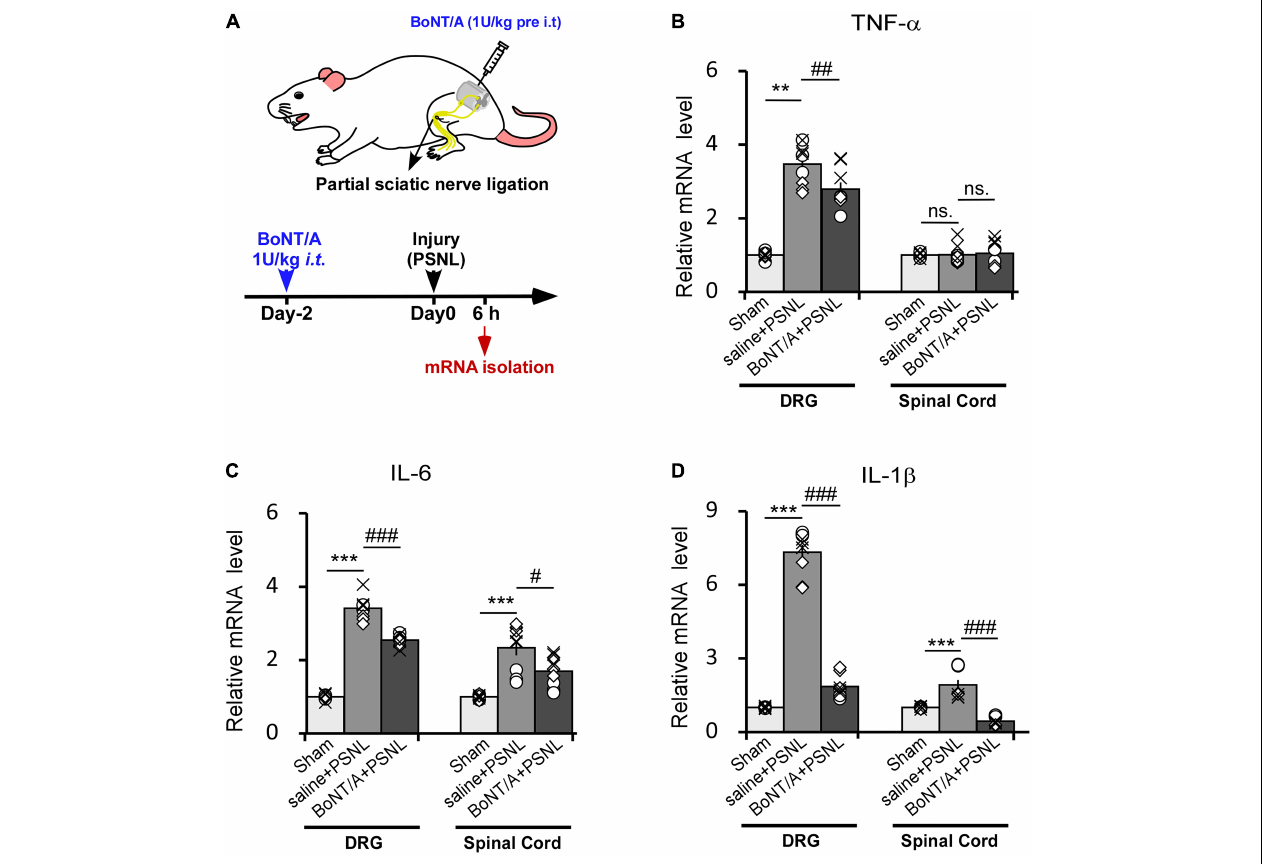
FIGURE 3 | Intrathecal pre-administration of BoNT/A partially prohibits partial sciatic nerve ligation (PSNL)-induced pro-inflammatory cytokine release in rat DRGs and the spinal cord dorsal horn. (A) A schematic illustration showing the protocol where BoNT/A was intrathecally ( i.t. , 1 U/kg) injected into spaces between the L5 and L6 spinal segments 2 days before PSNL surgery in rats. Six hours after PSNL surgery, the total mRNA was extracted from the DRGs and ipsilateral spinal cord dorsal horn, and the mRNA expression levels of the pro-inflammatory cytokines were detected. (B–D) mRNA expression levels of TNF- α (B) , IL-6 (C) , and IL-1 β (D) relative to β -actin. Data are presented as the fold change compared to the control group (nerve was exposed without ligation). Three mice were used for each group with 4 replicates for each experiment. Data are represented as the mean ± SEM. A non-parametric two-tailed t -test was used for comparison. *** p < 0.001 and ** p < 0.01 compared to control group, ### p < 0.001, ## p < 0.01, and # p < 0.05 compared to the PSNL group. ns. = no